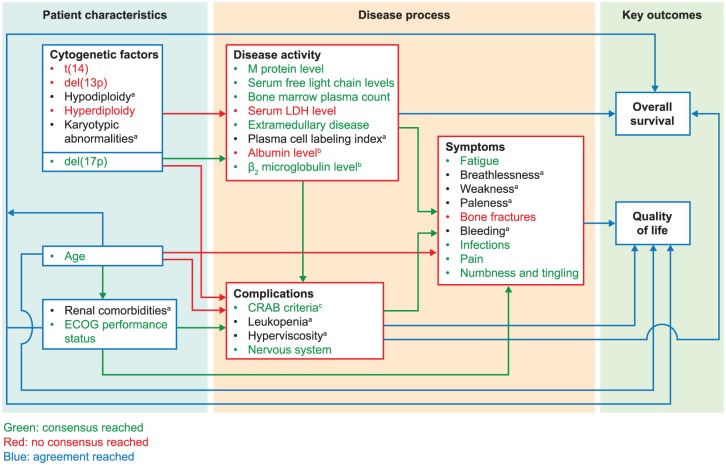
Map of associations between attributes that impact on disease progression
and patient outcomes: results from the literature review and Delphi
panel validation.CRAB, hypercalcemia, renal insufficiency, anemia, and lytic bone lesions
or osteoporosis; ECOG, Eastern Cooperative Oncology Group; ISS,
International Staging System; LDH, lactate dehydrogenase; MM, multiple
myeloma.
aInsufficient data available.
bEstimated from ISS stage at diagnosis.
cCRAB criteria.Consensus was defined as agreement among all four panel members.
Agreement was defined as 50% or more of panel members holding the same
opinion (considered sufficient for this exercise because MM is a
heterogeneous disease and it was important not to exclude relevant
attributes at this early stage of model development). In addition, if
only two of the Delphi panel members had the same opinion, the other two
panel members were required to hold different opinions from each other
for “agreement” to be reached. All included associations were agreed by
at least 50% of the panel.